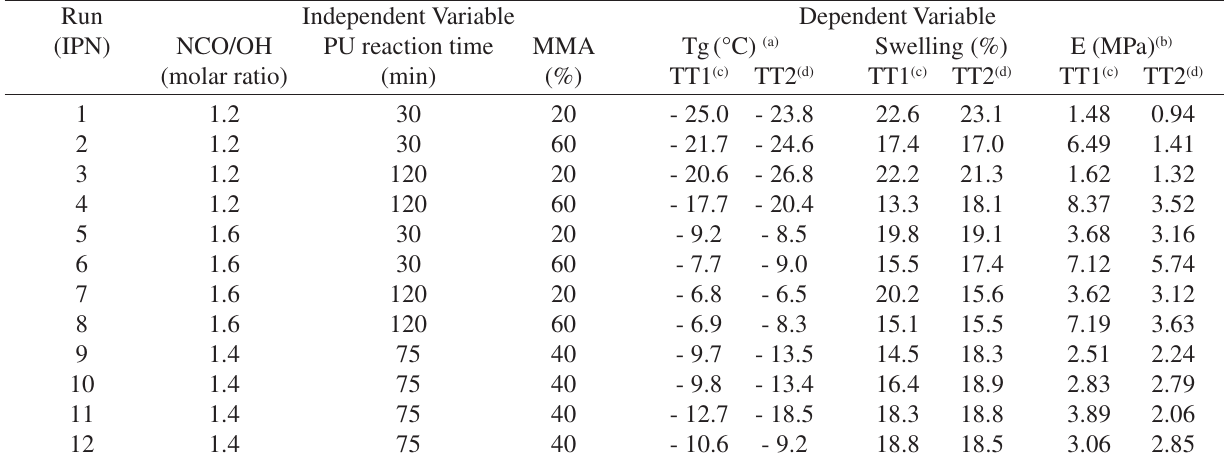
Table 2. Tg, swelling and elastic modulus of semi-IPNs cured according to thermal treatment